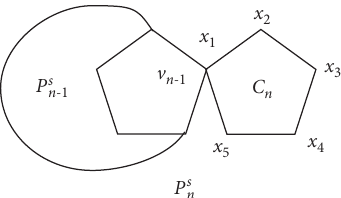
Figure 5: A spiro-pentachain P s